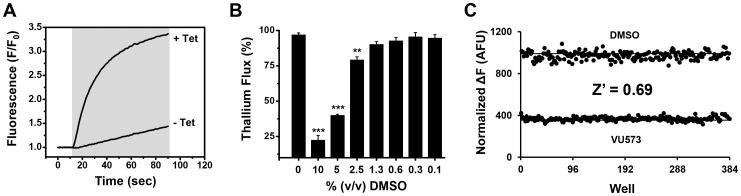
Tl+ flux assay of AeKir1 channel activity for high-throughput screening.(A) Representative Tl+-induced changes in Thallos fluorescence in T-Rex-HEK293-AeKir1 cells cultured overnight with (+Tet) or without (-Tet) tetracycline. The shaded box indicates the cell exposure to Tl+. (B) DMSO concentrations up to 1.3% v/v DMSO have no effect on Tl+ flux through AeKir1. Data are means ±SEM (n = 3). One-way ANOVA P<0.0001, and asterisks (**, ***) indicate P<0.01 or P<0.001 respectively, when compared to 0% DMSO (Tukey's test). (C) Representative checkerboard analysis using 100 µM VU573 or 0.1% v/v DMSO as the vehicle control. The mean peak fluorescence amplitude of each sample population is indicated with a solid line and alternating samples for DMSO (top) and VU573 (bottom) are graphed as individual points. The mean ±SD Z′ calculated over 6 plates on 3 separate days was 0.69±0.05.